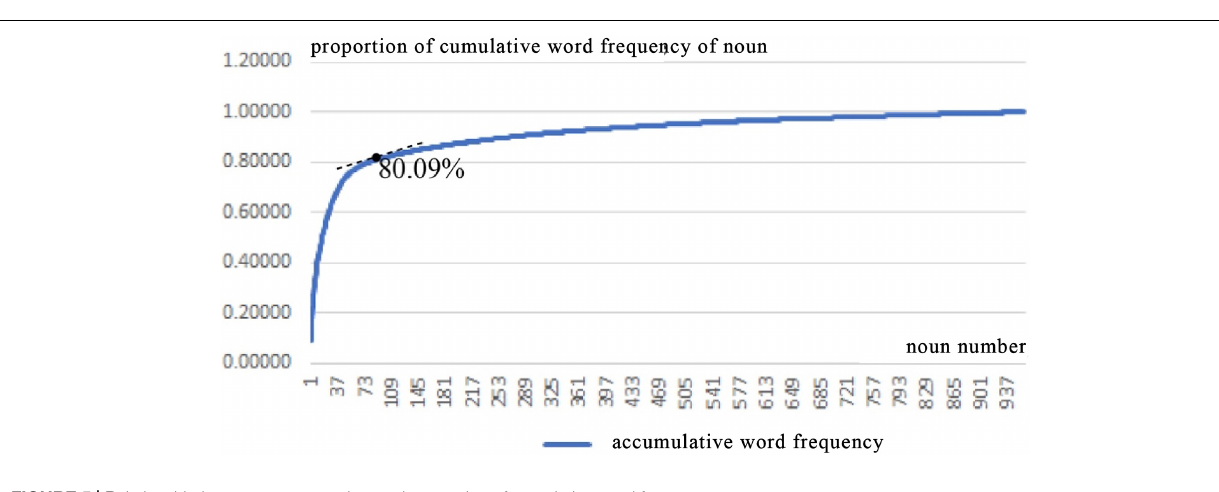
FIGURE 5 | Relationship between noun number and proportion of cumulative word